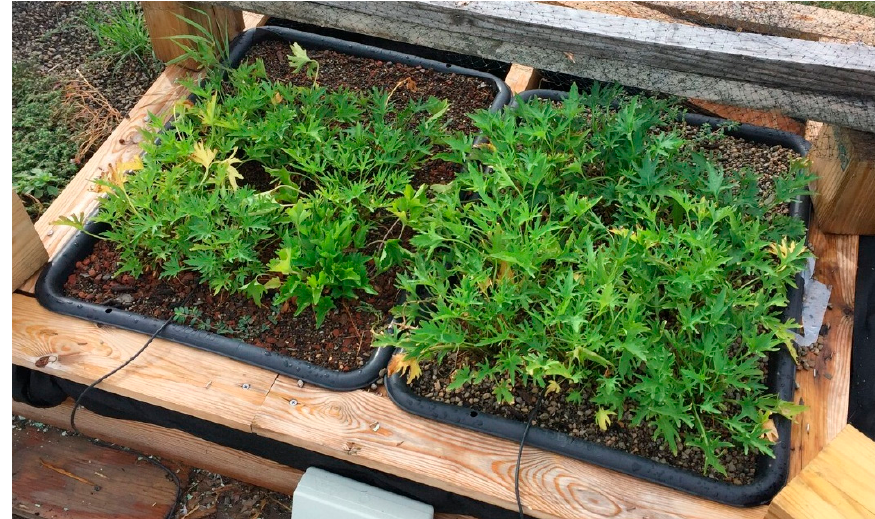
Figure 5. Vegetated ( Viola pedatifida , Prairie Violet) green roof media. Growth media with the dredged material ( left ) and Rooflite ® growth media ( right ).